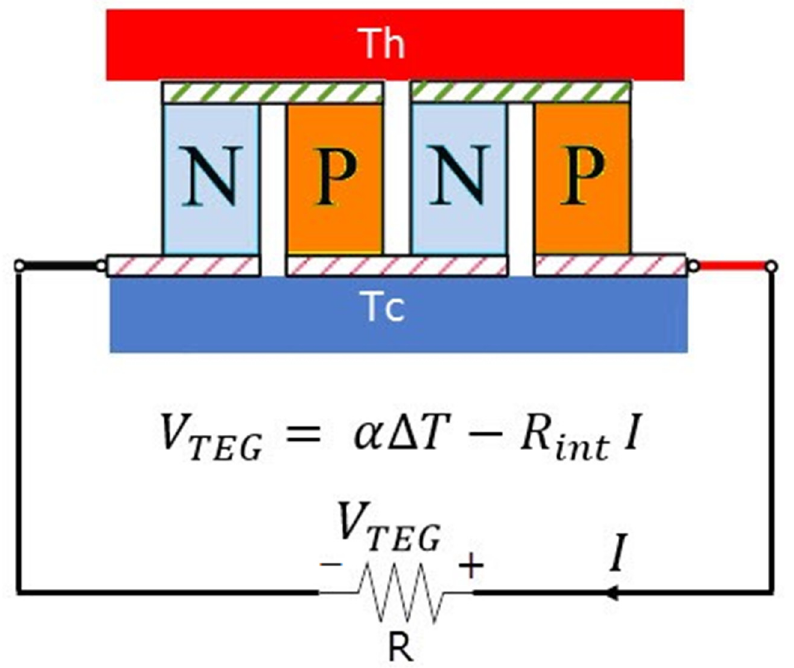
Figure 1. Simple diagram of a thermoelectric generator (TEG).